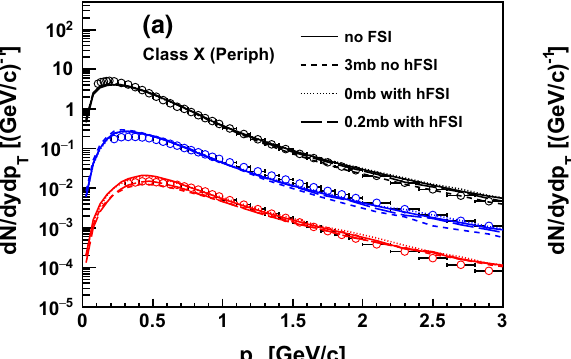
actions (solid line), only parton rescatterings (short dashed line), only hadron rescatterings (dotted line) and combined parton/hadron rescat- terings (long dashed line). ALICE data are taken from [16]